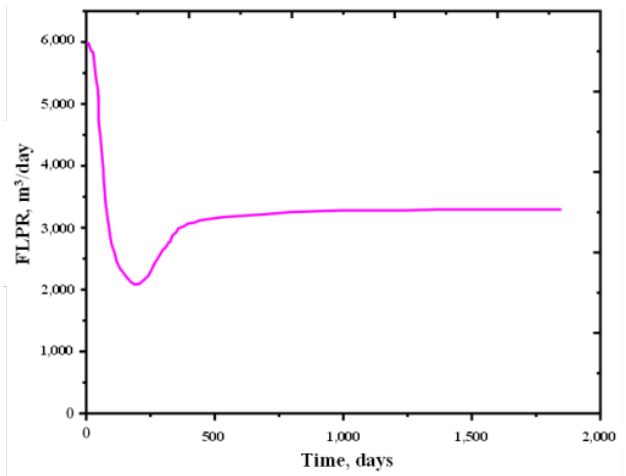
Figure 12. Field liquid production rate for horizontal well.